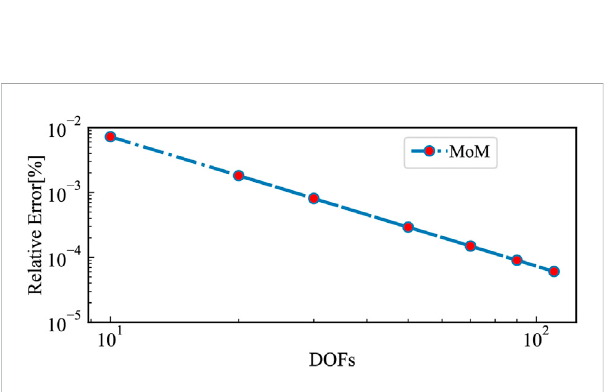
FIGURE 5 Convergence results of the average error in terms of the MOM calculation DoFs.